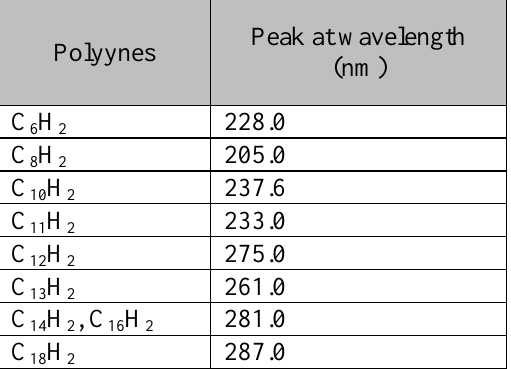
Fig.3: FTIR spectrum of CNPs suspensions at different laser pulse a) 25 pulse/80mJ b) 100 pulse/80mJ. Table1: The polyynes at ethanol suspension prepared at different laser pulse and different laser